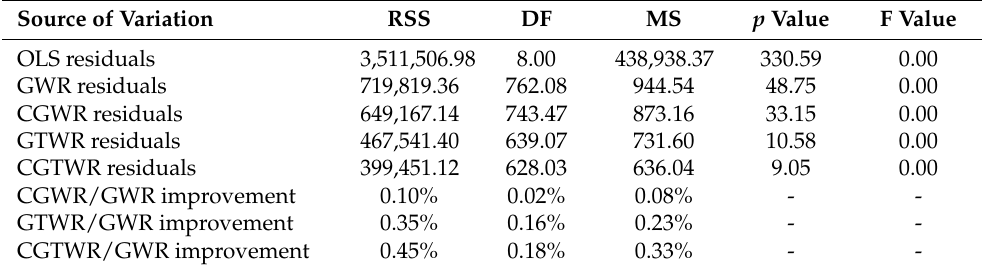
Table 3. ANOVA comparisons among the OLS, GWR, CGWR, GTWR and CGTWR models.